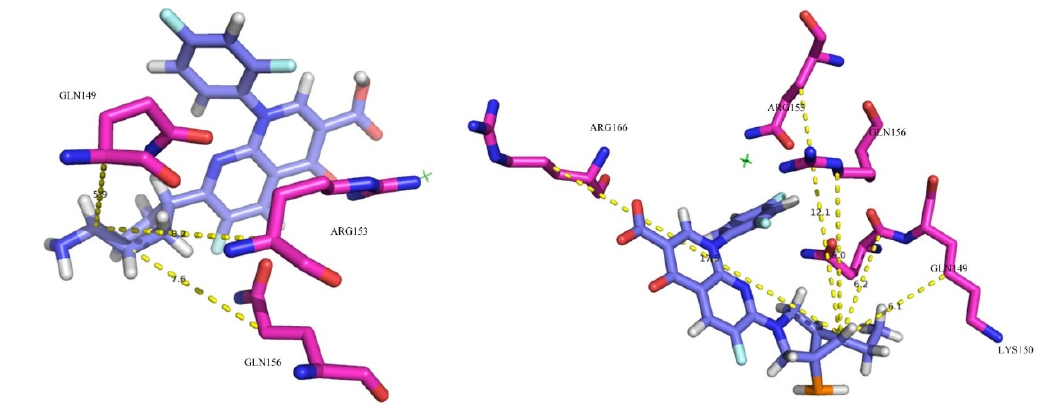
Figure 5. Binding conformation of trovafloxacin and derivative-10 with plasma protein ligand in binding domain.